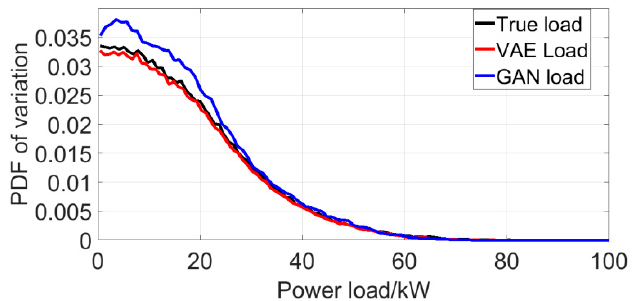
Figure 10. Probability density function of load variation.